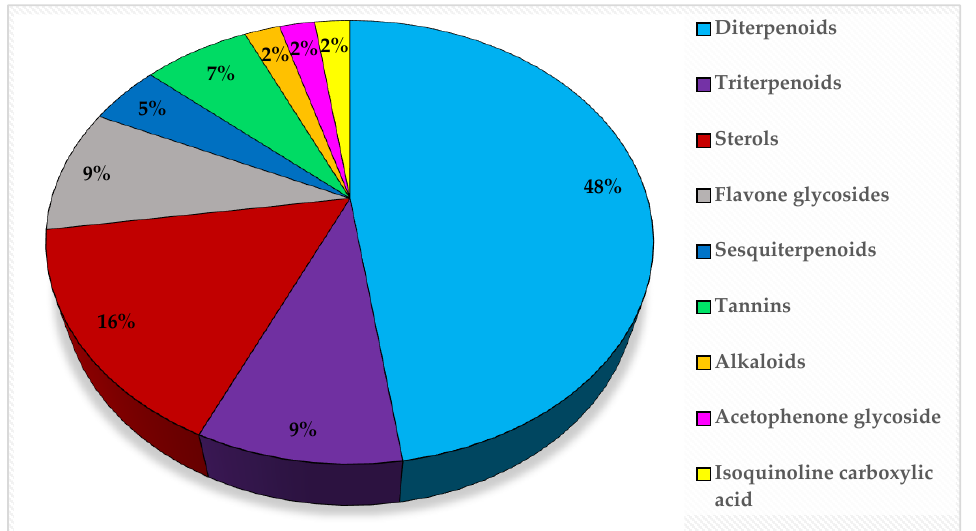
Figure 1. Percentage of different classes of metabolites distributed in the tested 15 Euphorbia species.